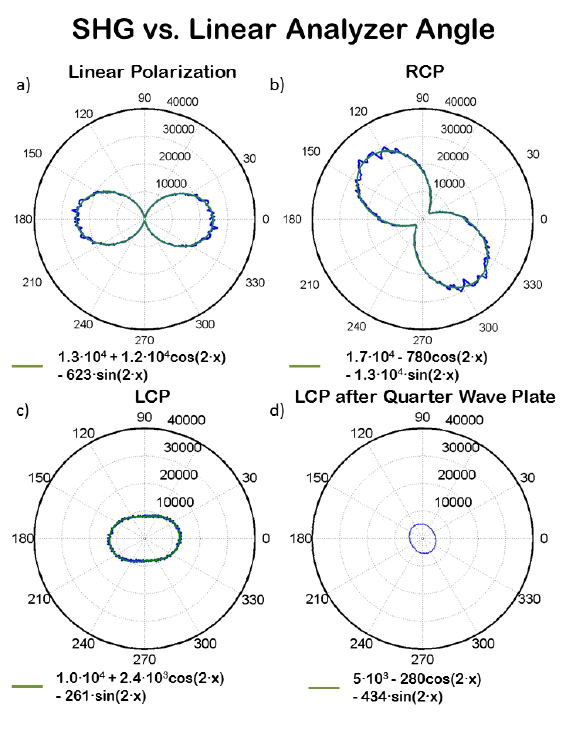
Figure 4: Polar plots as a function of linear analyzer angle placed af- ter the nanoparticles in a-c) for a linear polarizer. d) Used a quarter- wave plate before the linear analyzer. These measurements were fitted to a first-order Fourier function to determine the polarization state of the emitted light. a) Shows that linearly polarized incident light creates linearly polarized harmonic light that was coaxial with the fundamental. b) Shows that right-handed circularly polarized tion of the polarization axis by 45 degrees. Shows that left-handed circularly polarized light creates harmonic light with no dominant axis of polarization. d) Shows that the measurements taken in c) was a superposition of all polarizations. SHG: Second-harmonic generation